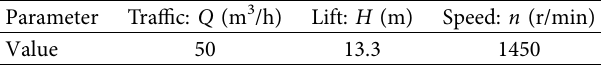
Table 1: Basic design parameters of the plastic centrifugal pump.